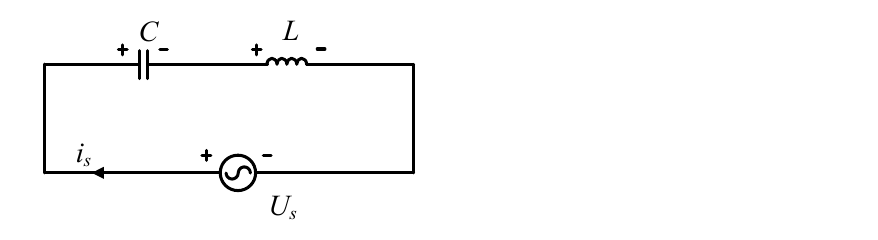
Figure 1. The circuit consists of an inductor and a capacitor shown inertia.